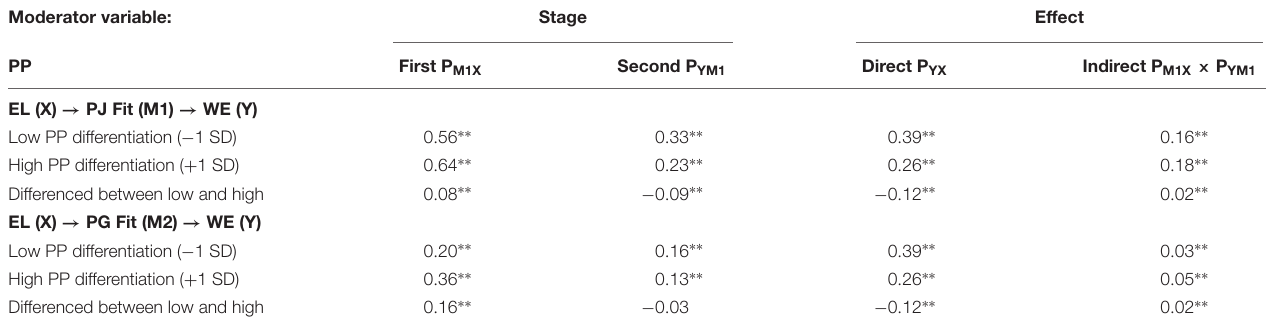
TABLE 5 | Results of the moderated